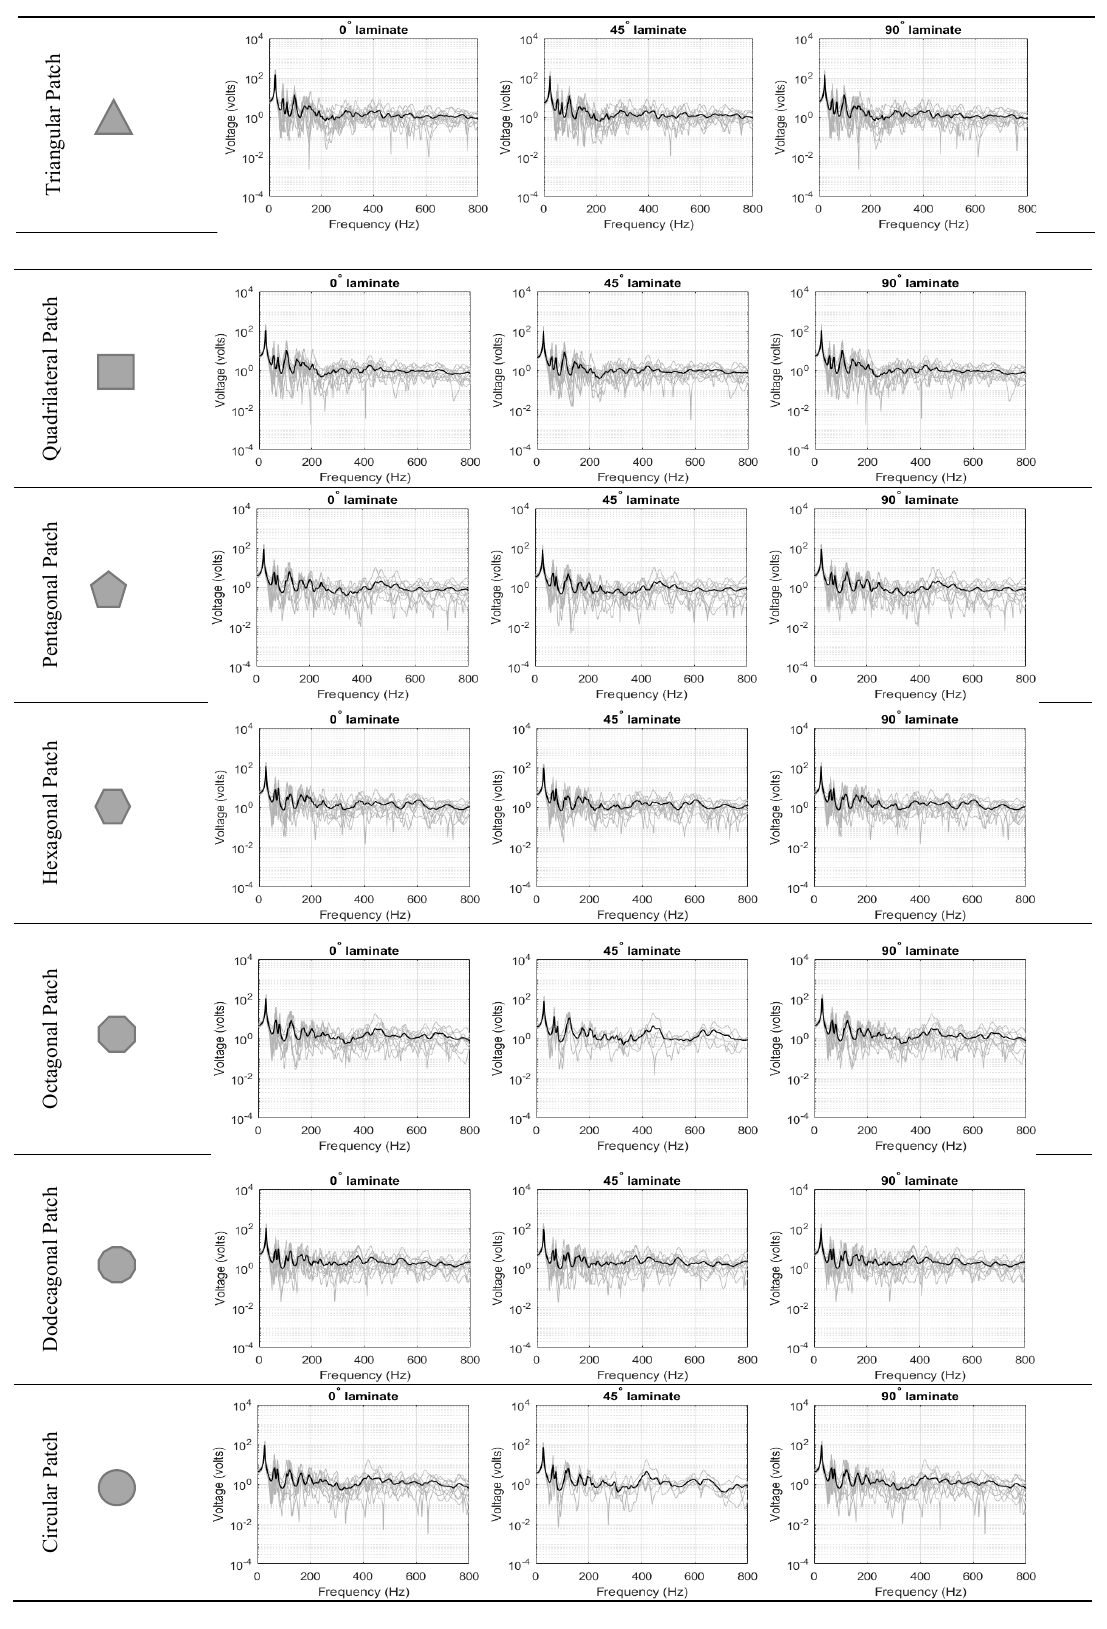
Figure 6. Ensemble-average voltage response for single-lamina.